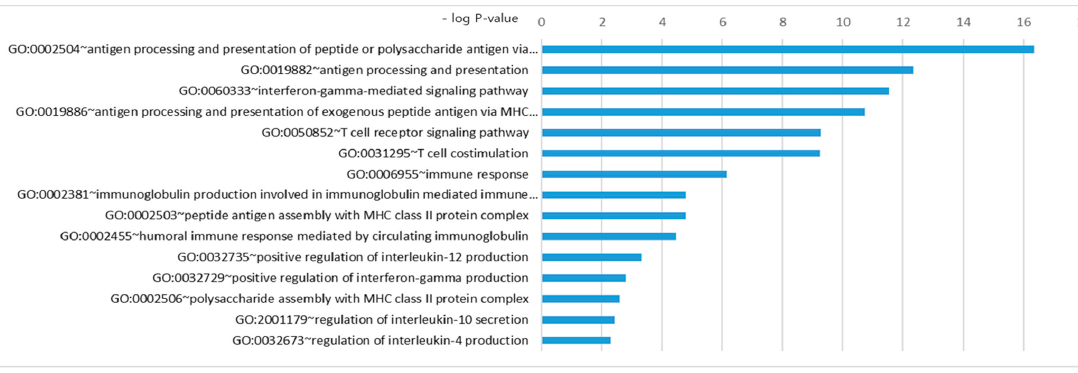
Figure 4. Gene ontology enrichment analysis of ANCA-associated vasculitis. The analysis was performed with the associated genetic variants. The cut-off p-value for this analysis was 0.01 ( − log p -value = 2). Other subtype results are shown in the Figure S3.